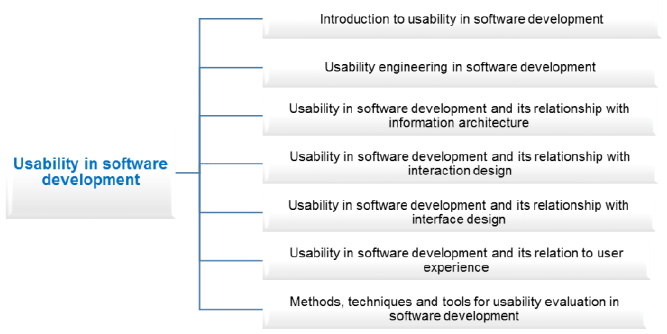
Fig. 2. The topics proposed for inclusion in the subject Usability in software